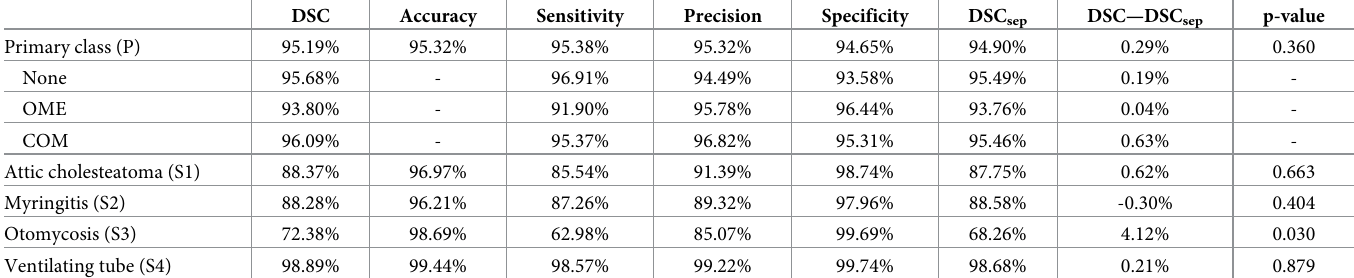
Table 1. Prediction performance of combined model for primary and secondary classes. McNemar test was applied for the comparison with separate models, denoted with the subscript ’sep’.